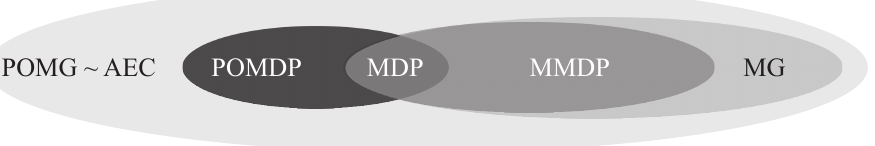
Figure 3. Venn diagram of the decision processes according to [38]. According to the diagram: MDP ⊂ MMDP ⊂ MG ⊂ POMG and MDP ⊂ POMDP ⊂ POMG and POMG ∼